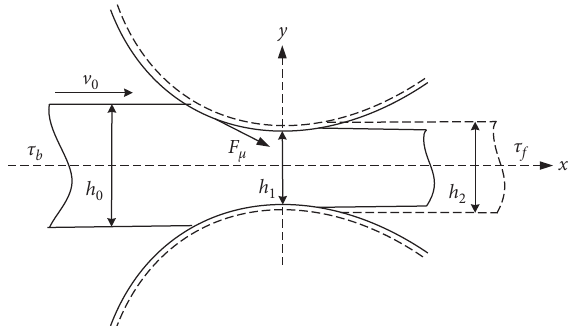
Figure 4: Dynamic rolling process in the deformation